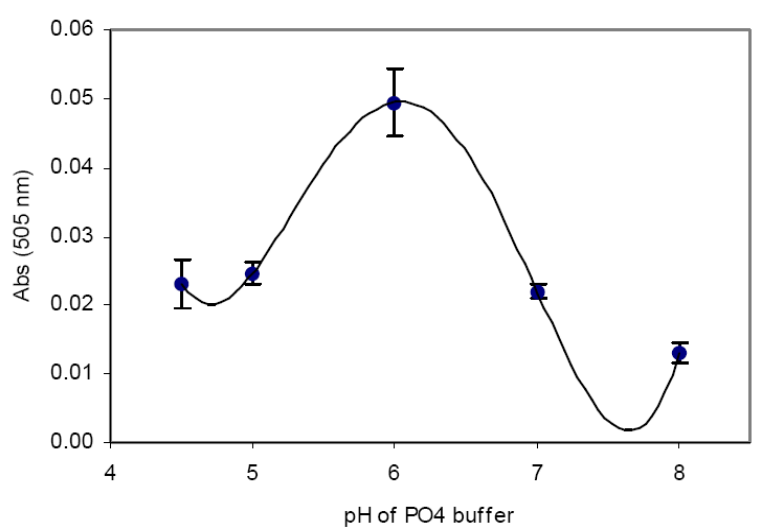
Figure 6 . The effect of the variation in the pH of buffer on the biosensor